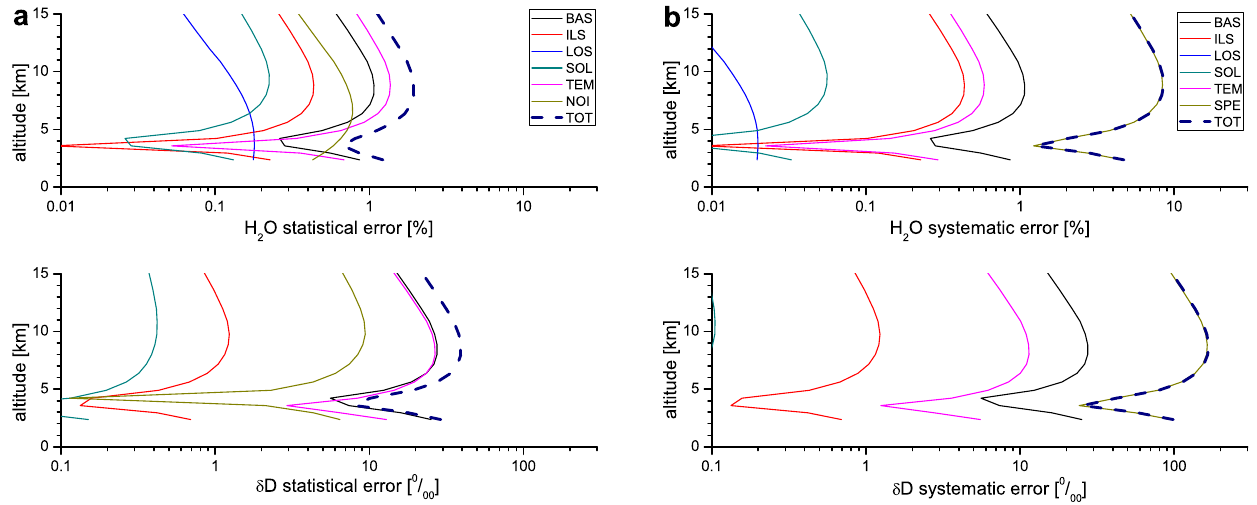
Fig. 6. Same as Fig. 5 but for H 2 O (top panels) as well as δ D (bottom panels) and after applying the a posteriori operator of Eq. (14). Table 5. Same as Table 4 but for δ D and with smoothing as well as cross-state error (cross-dependence on humidity).